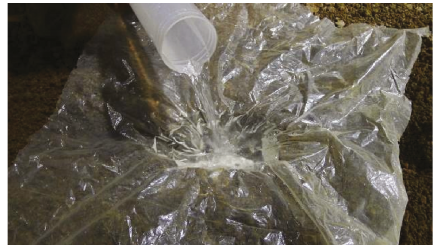
Figure 11: Methods for measuring the volume of depression.